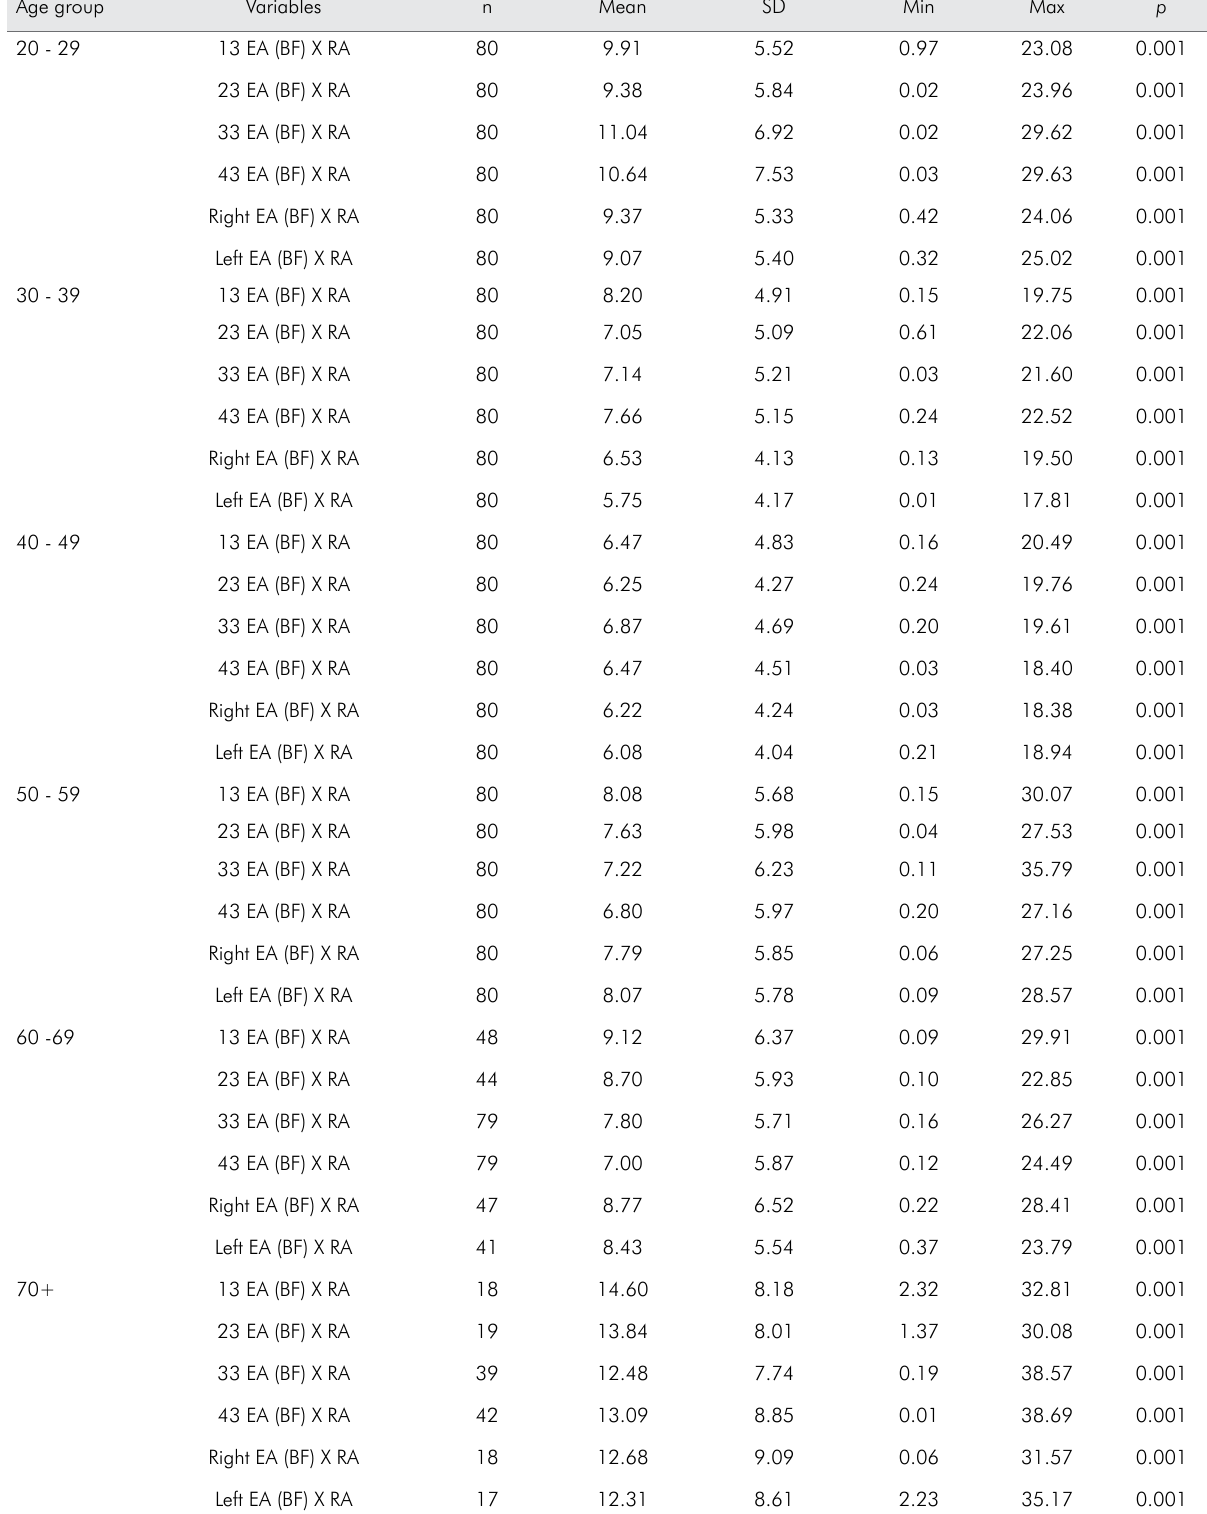
Table 3. Comparisons between the real age (RA) and age obtained using the Brazilian formula (BF) among the age groups. Age